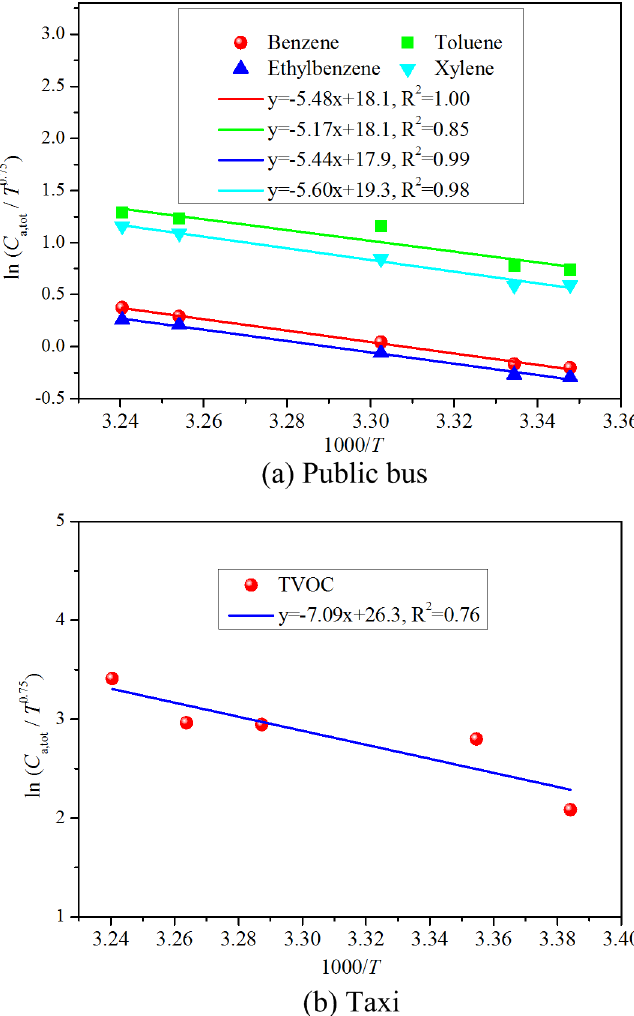
Fig 6. Validation of correlation (16) with Chen et al. ’ s [29, 46] experimental data from vehicular